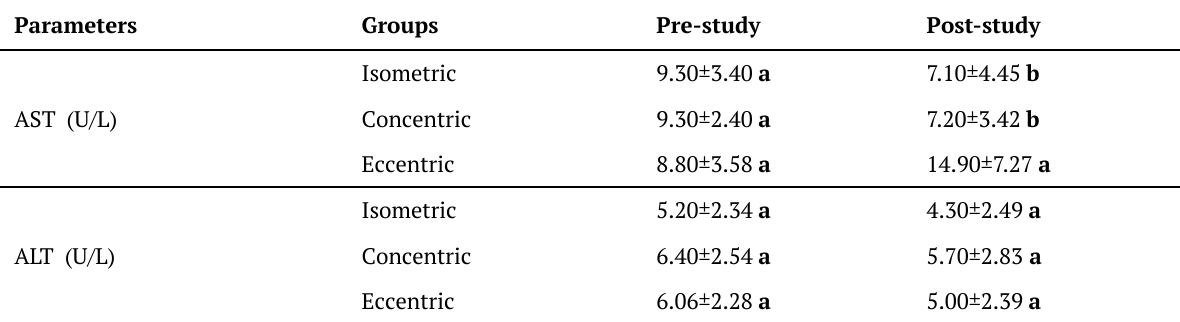
Table 5. Comparison of Serum AST and ALT levels between groups before and after the study